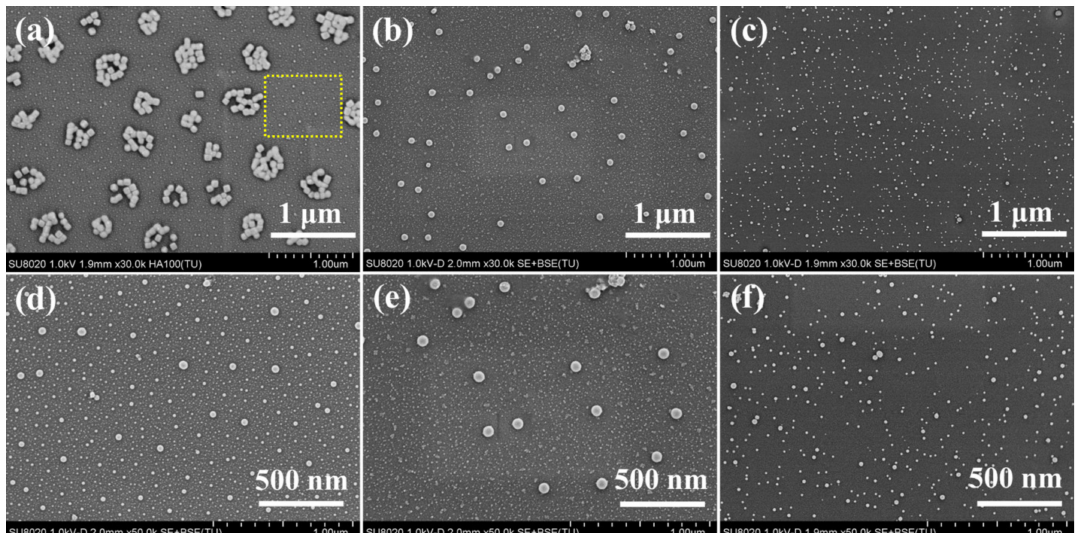
Figure 3. Field emission scanning electron microscope (FESEM) images of Ag 2 S nanoparticles obtained